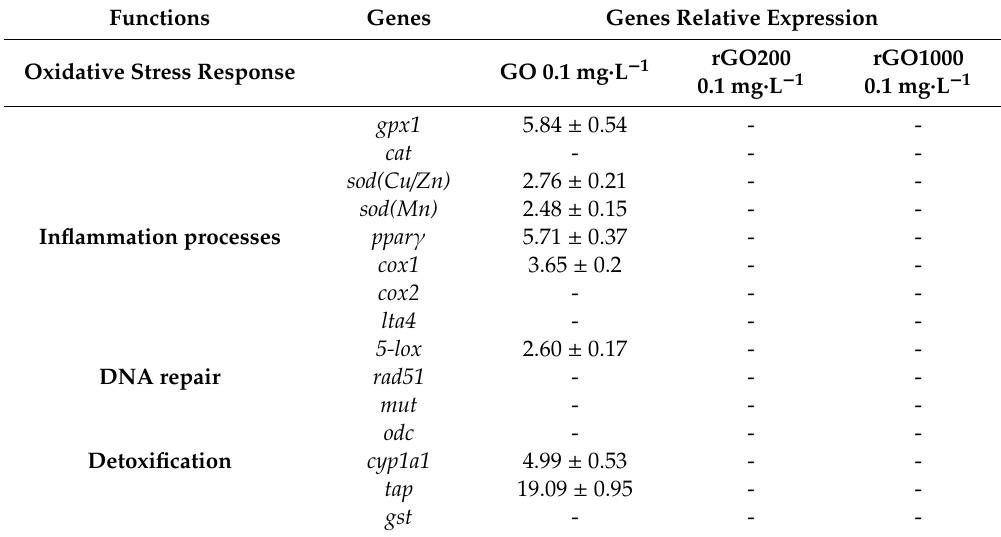
Table 4. Di ff erential gene expression in Xenopus larvae liver (n = 5) after 12 days of exposure to GO, rGO200 and rGO1000 at 0.1 mg · L − 1 . For each condition, results are given as induction ( > 1) or repression ( < 1) factors compared to the negative control. Only statistically significant values are given; “-” indicates factors similar to control